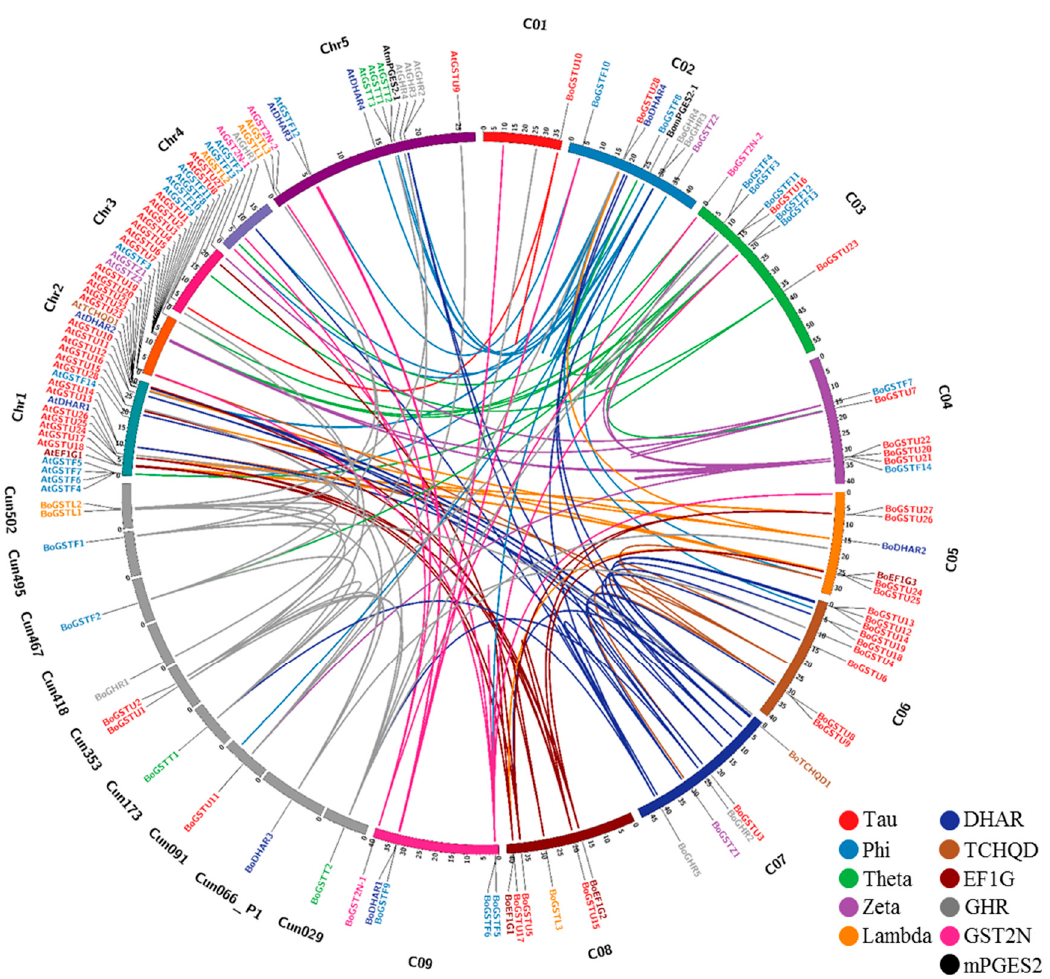
Figure 3. Comparative genome mapping of orthologous and paralogous GST ’s genes between B. oleracea and Arabidopsis chromosomes. A high level of conserved syntenic regions between the two species was evident.